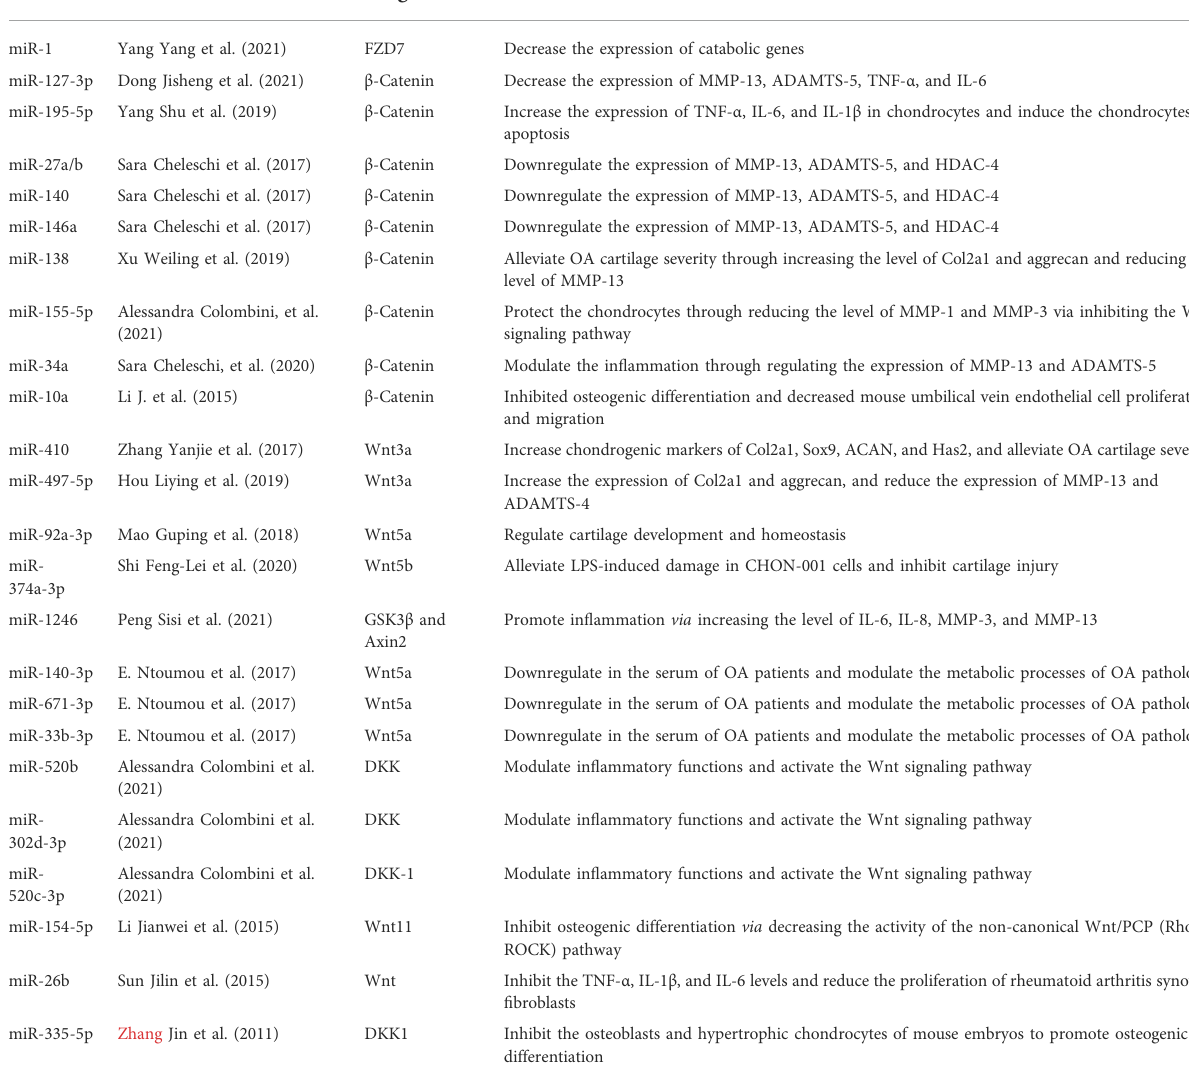
TABLE 3 miRNAs targeting the Wnt signaling pathway in the pathogenesis of